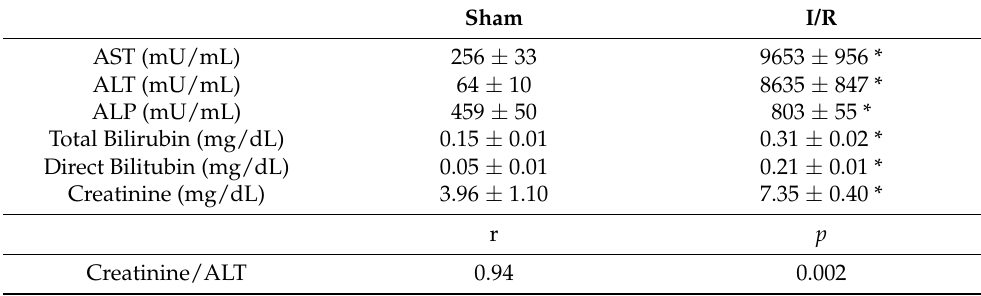
Table 1. Serum biochemical parameters in sham and I/R rats and creatinine/ALT